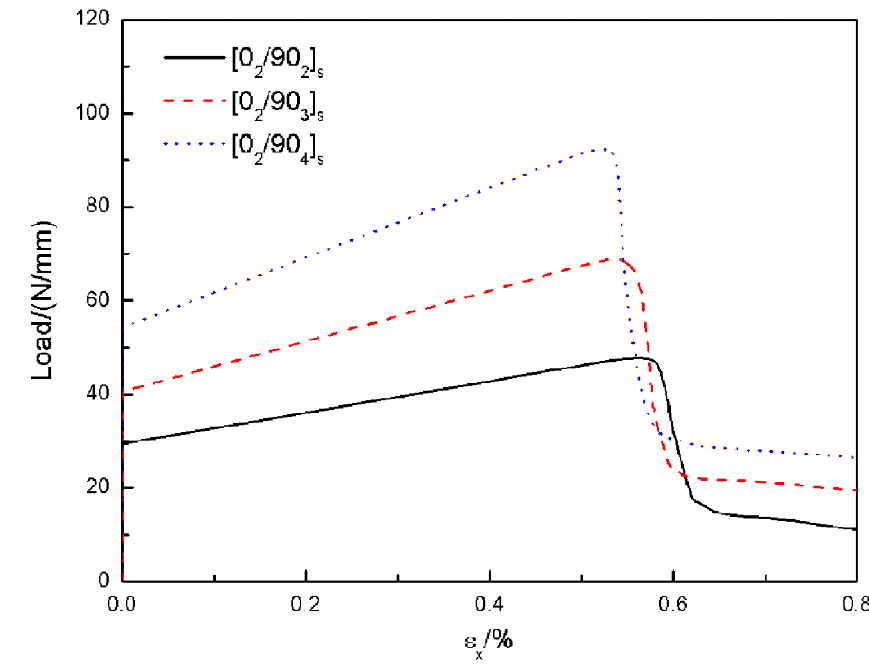
◦ plies of the three cross-ply